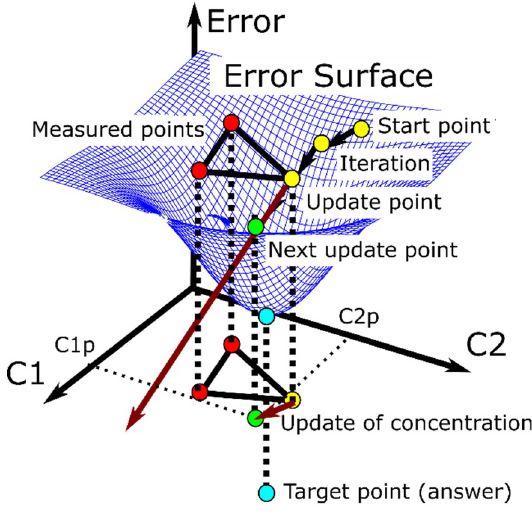
Figure 5. Gas mixture quantification for a binary gas mixture. The error surface is determined by the gas mixture composition and a target of gas mixture data. The gradient is calculated from three points, and the update point goes straight ahead in the direction of the maximum slope. This process is iterated until the update point reaches the target point, which has the minimum value in the error surface.